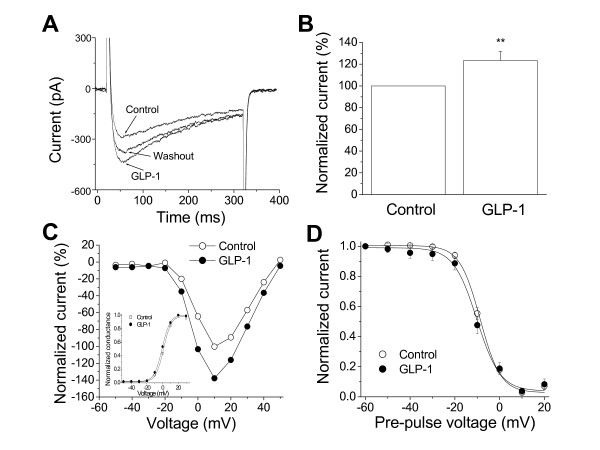
Effects of GLP-1 on voltage-gated L-type Ca2+ currents in isolated canine left ventricular myocytes. The representative traces of ICa in the absence (Control and Washout) and presence (GLP-1) of 5 nM GLP-1 are shown in panel A. The currents were evoked by the depolarizing pulses from the holding potential of -40 mV to 0 mV every 10 s. The current traces represented the ICa recorded at the times just before GLP-1 (Control), 12 min after GLP-1 perfusion (GLP-1), and 10 min after washout of GLP-1 (Washout). Panel B shows the average increase in the peak ICa in the presence of 5 nM GLP-1 (n = 7, p < 0.01). Panel C shows the effects of 5 nM GLP-1 on the current-voltage relationship of ICa recorded from a representative myocyte in the presence (solid circle) and absence (open circle) of 5 nM GLP-1. The normalized currents were calculated as the ratio of the peak ICa,GLP-1 to the maximal peak ICa,Control. The voltage protocol was composed of a group of pulses from -50 mV to 50 mV with 10 mV increments every 10 s. The membrane holding potential was -40 mV. The inset in the panel C shows the activation curves in the presence (solid circle) and absence (open circle) of 5 nM GLP-1. Panel D shows the steady-state inactivation of L-type Ca2+ currents (n = 7) in the presence (solid circle) and absence (open circle) of 5 nM GLP-1. The voltage protocol had double pulses consisting of a 200-ms test pulse to 0 mV following a 500-ms conditioning pulse varying from -60 to 20 mV in 10-mV increments every 10 ms with membrane holding potential of -40 mV. Normalized inactivation data were fit to a Boltzmann equation (solid lines): y = 1/{1 + exp[(V + V0.5)/K]}, where V0.5 is the voltage at which y = 0.5 and K is the slope factor.